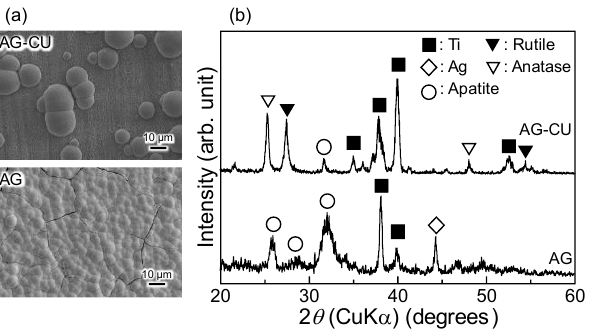
Figure 3. ( a ) SEM images and ( b ) TF-XRD patterns of samples after immersion in SBF for 7 days.